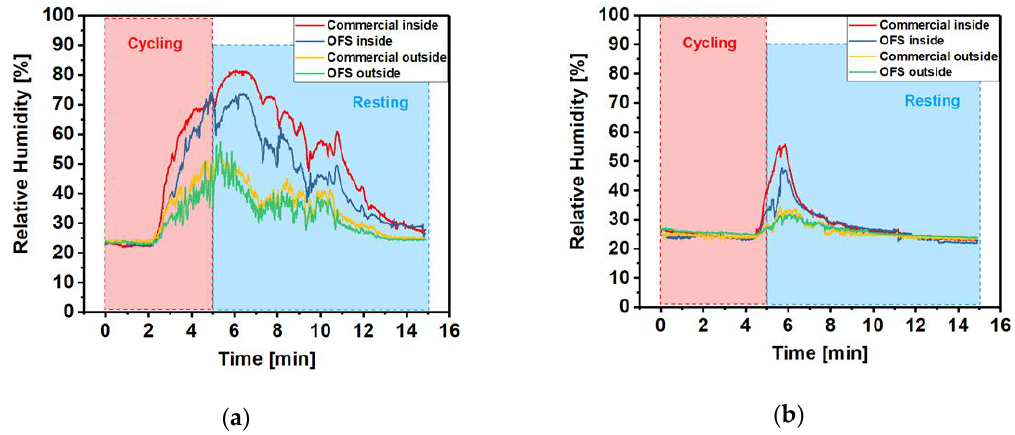
Figure 7. The RH reading from the sensing probe (inner, blue curve and outer, green curve) and commercial sensor (inner, red curve and outer, yellow curve) measured during the cycling exercise with 100% cotton T-shirt ( a ) and 100% polyester T-shirt ( b ) of volunteer 1. Cotton is a hydrophilic material and polyester has hydrophobic property [7,27]. It can be seen from the two graphs that there is a significant difference in RH readings between cotton and polyester cases. The amplitude of the RH reading has reached a maximum of 73.3% (OFHS) in the cotton case and a maximum of 47.7% in polyester. Moreover, when the volunteer wears a polyester T-shirt the humidity levels recovered much quicker than that in cotton case when the subject rests.